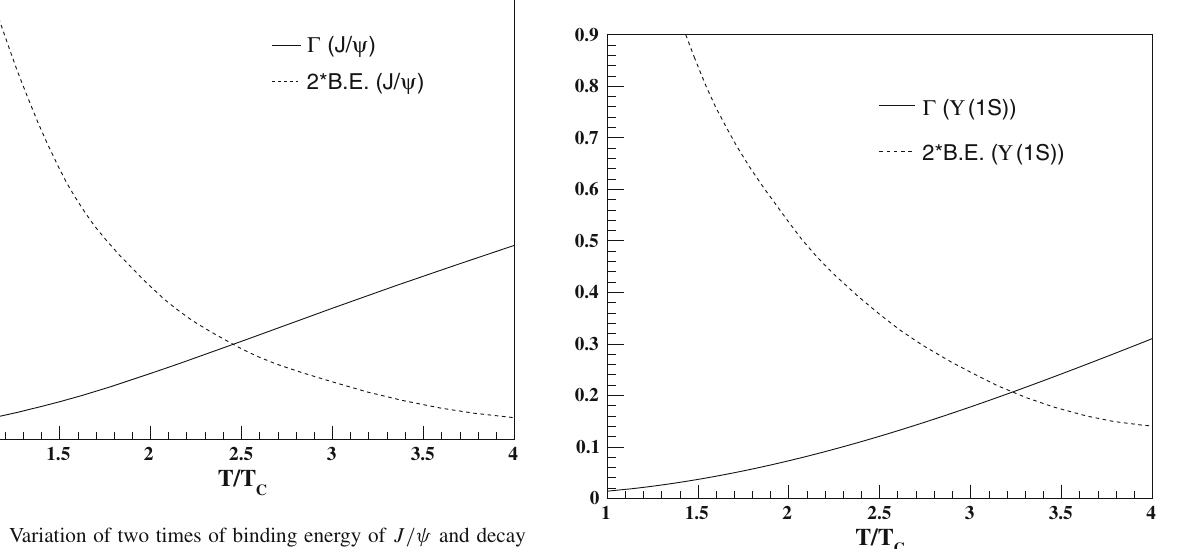
Fig. 17 Variationoftwotimesofbindingenergyof ψ (cid:8) anddecaywidth with respect to T / T C